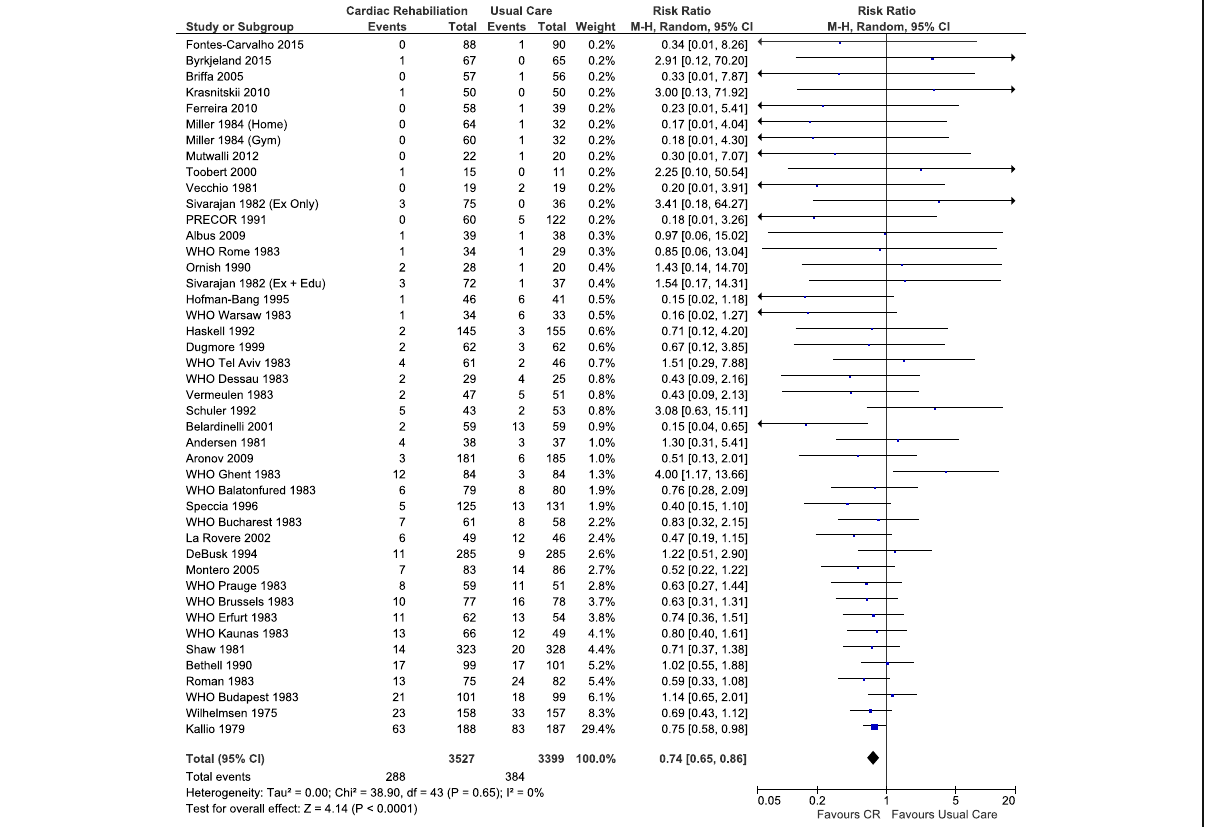
Fig. 2 Forest plot of the effect of exercise-based cardiac rehabilitation (vs usual care) on cardiovascular mortality across all types of interventions, CI confidence interval, CR cardiac rehabilitation